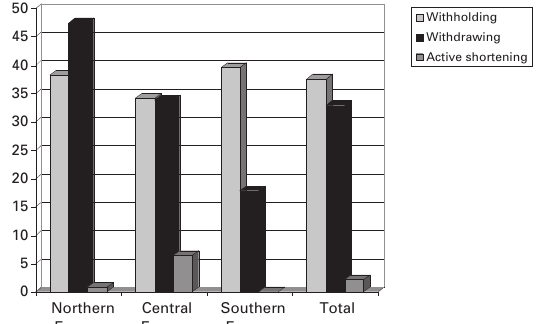
Differences in with- drawing, withholding and active shortening of dying process in European regions. Data from